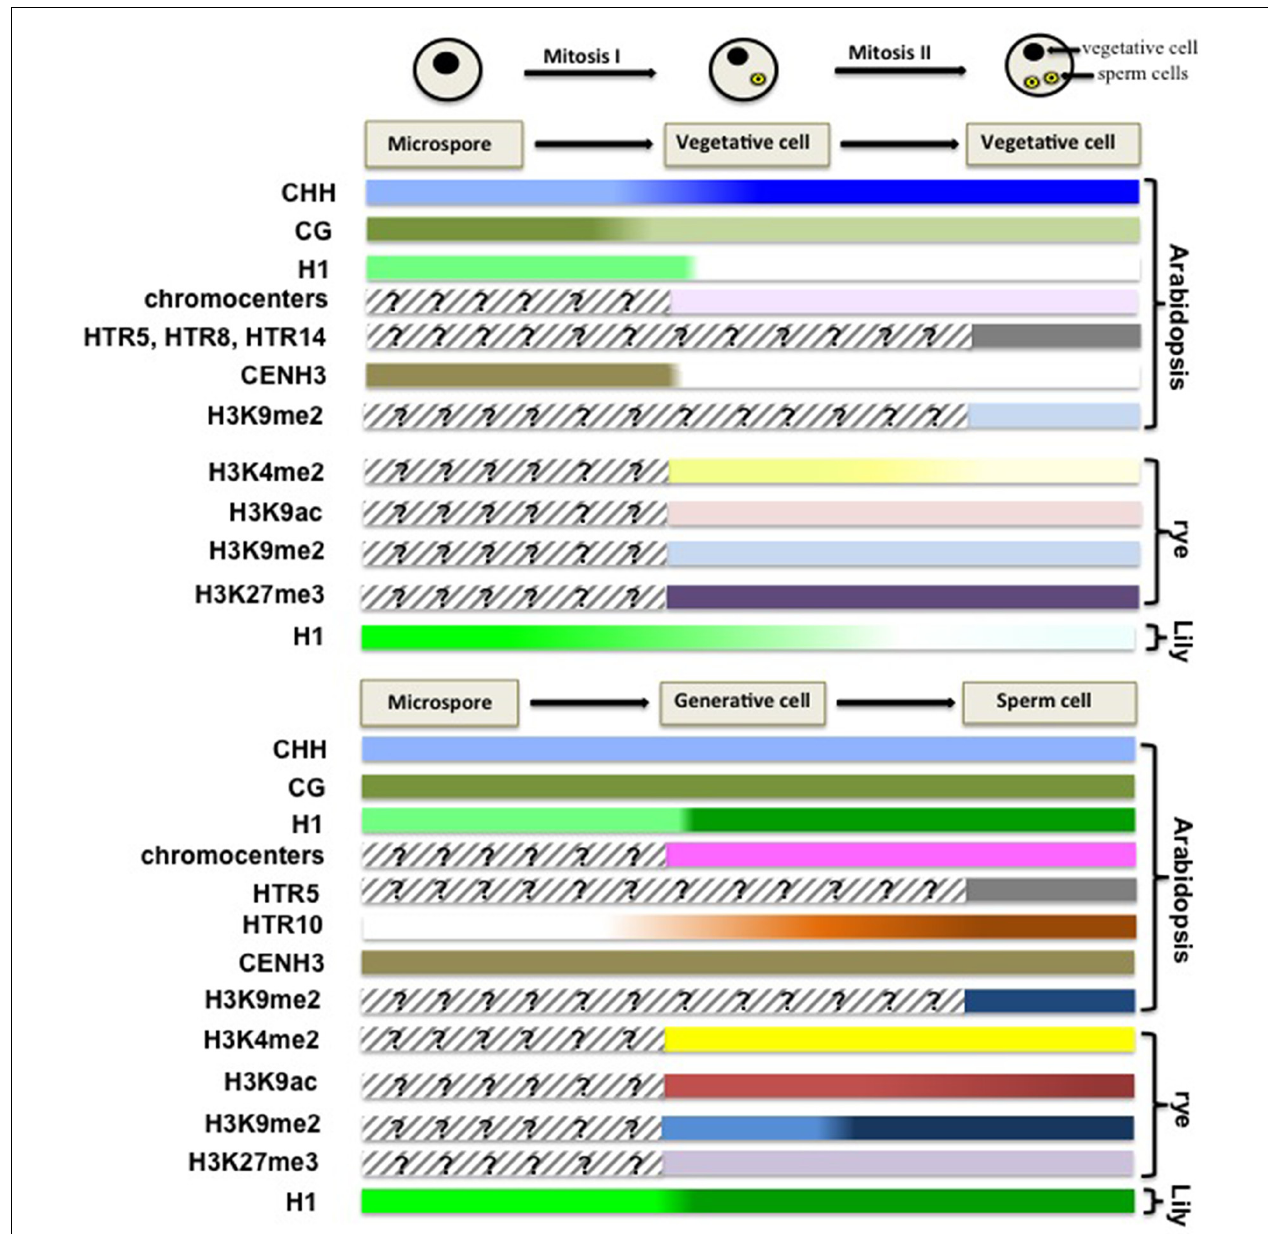
FIGURE 3 | Chromatin dynamics during male gametogenesis. This scheme summarizes cytogenetic and molecular profiling data suggesting large-scale chromatin dynamics events during male gametophyte development. Although disparate in the level of investigation and plant species analyzed it provides a conceptual framework, yet to be completed, for apprehending the extent and potential significance of chromatin dynamics during this developmental stage. In Arabidopsis , the microspore harbors low levels of CHH methylation at retrotransposon loci, but retains CG methylation. After the first mitosis, the vegetative nucleus restores CHH methylation, but undergoes CG demethylation at a subset ofTE loci (Calarco etal., 2012).The chromatin of the vegetative cell is highly decondensed, mostly deprived of linker H1 (Wenjing She and Célia Baroux, unpublished) and H3K9me2 (Schoft etal., 2009). Additionally, the somatic patterns of histone H3 variants are erased, and only a few H3 variants are retained